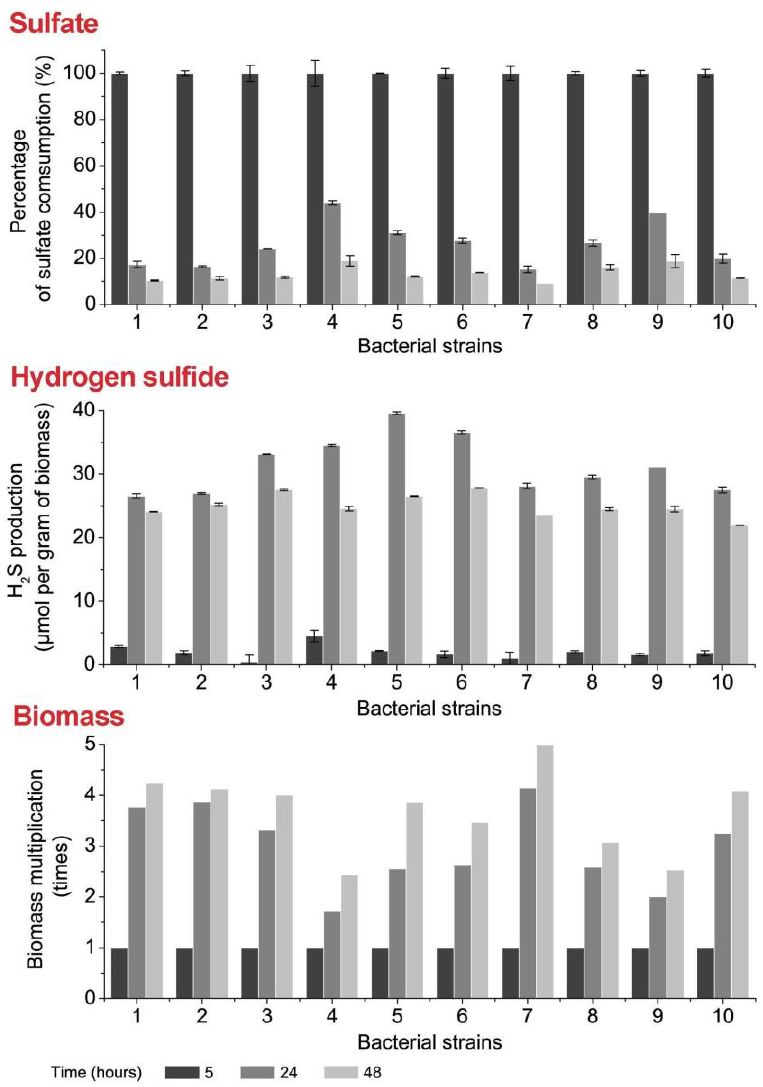
Figure 3. Sulfate consumption, H 2 S production and biomass accumulation by collected stains of SRB during 5, 24 and 48 h ( IBD : 1 —M1.1, 2 —M7.3, 3 —M8, 4 —M9.2, 5 —M9.3; healthy : 6 —Z8.2, 7 —Z9.2, 8 —Z9.3, 9 —Z11.1, 10